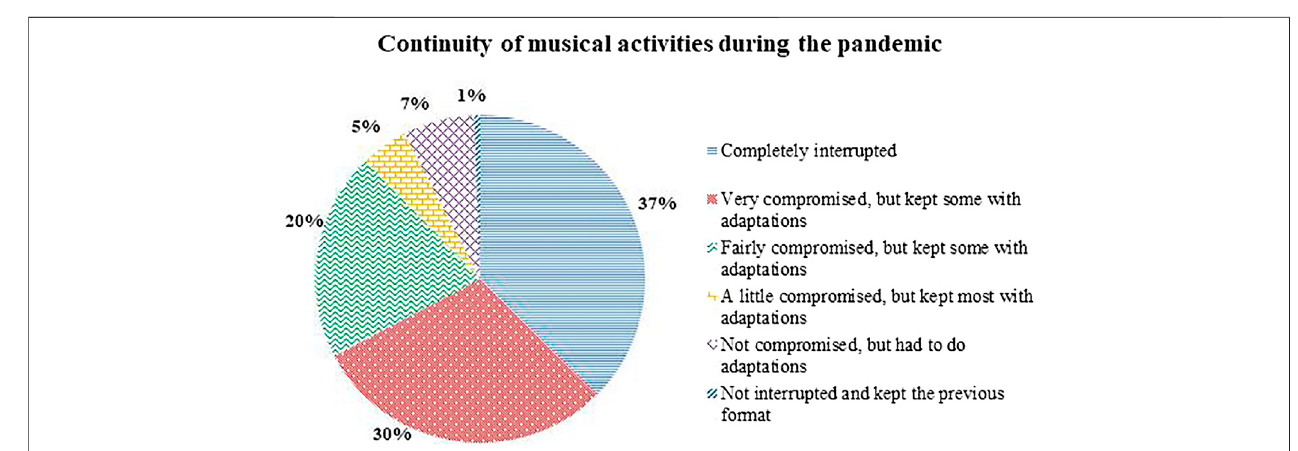
FIGURE 6 | Continuity of musical activities during the